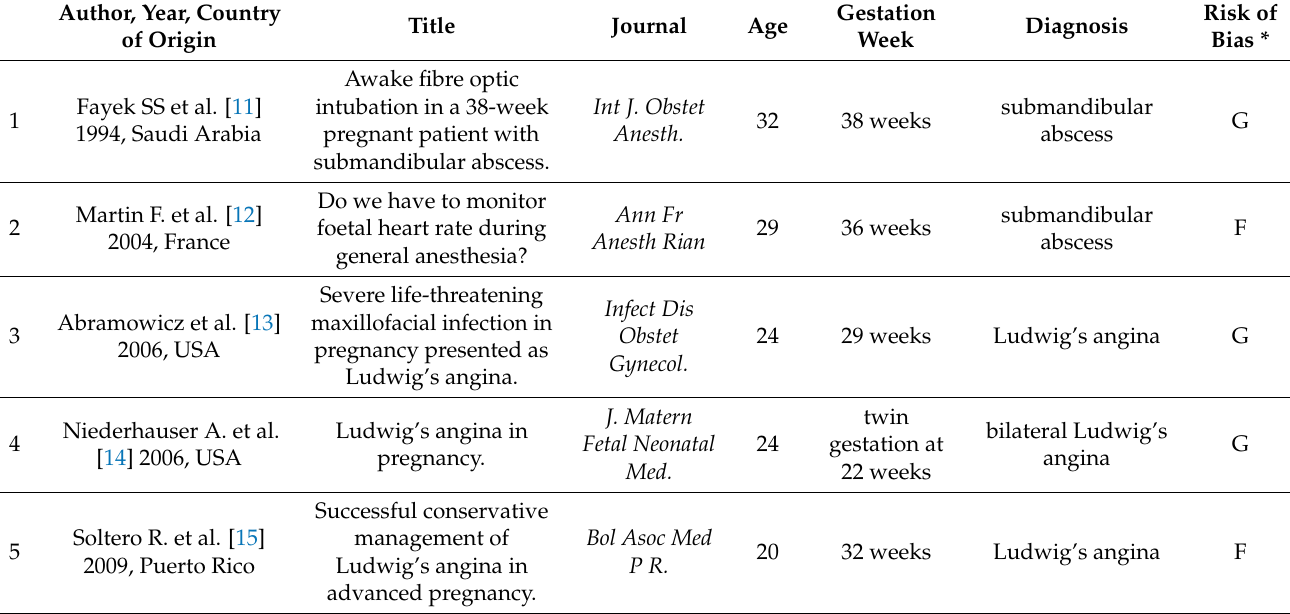
Figure 1. ( A ) Frontal view of the patient presenting submandibular swelling and trismus; ( B ) orthopantomography of the patient showing periapical abscess of the 4.6 tooth. Table 1. Characteristics of included case